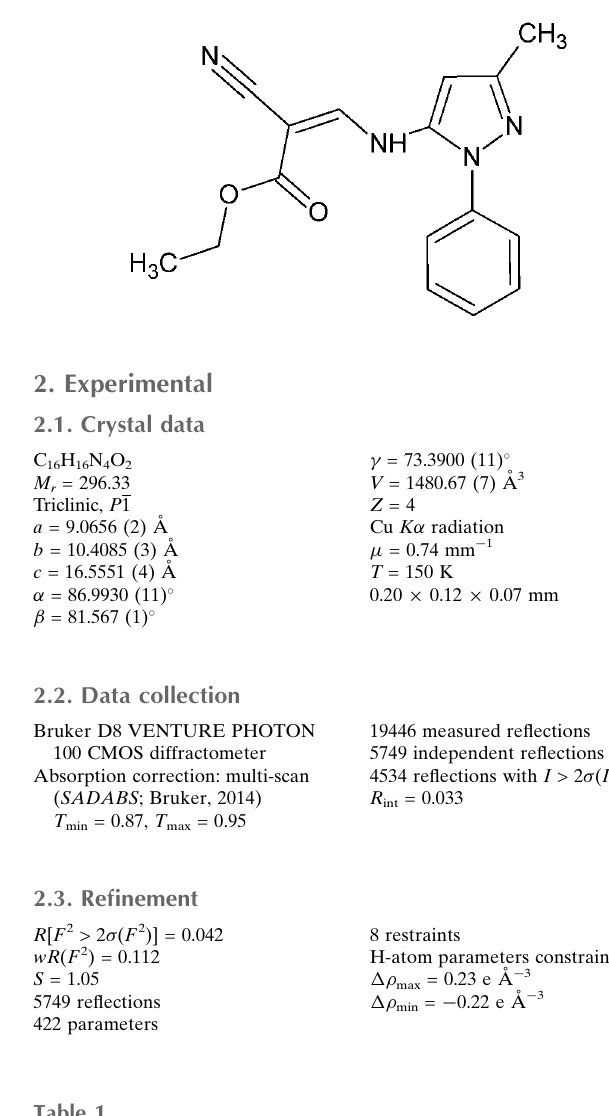
Hydrogen-bond geometry (A˚ , (cid:3)